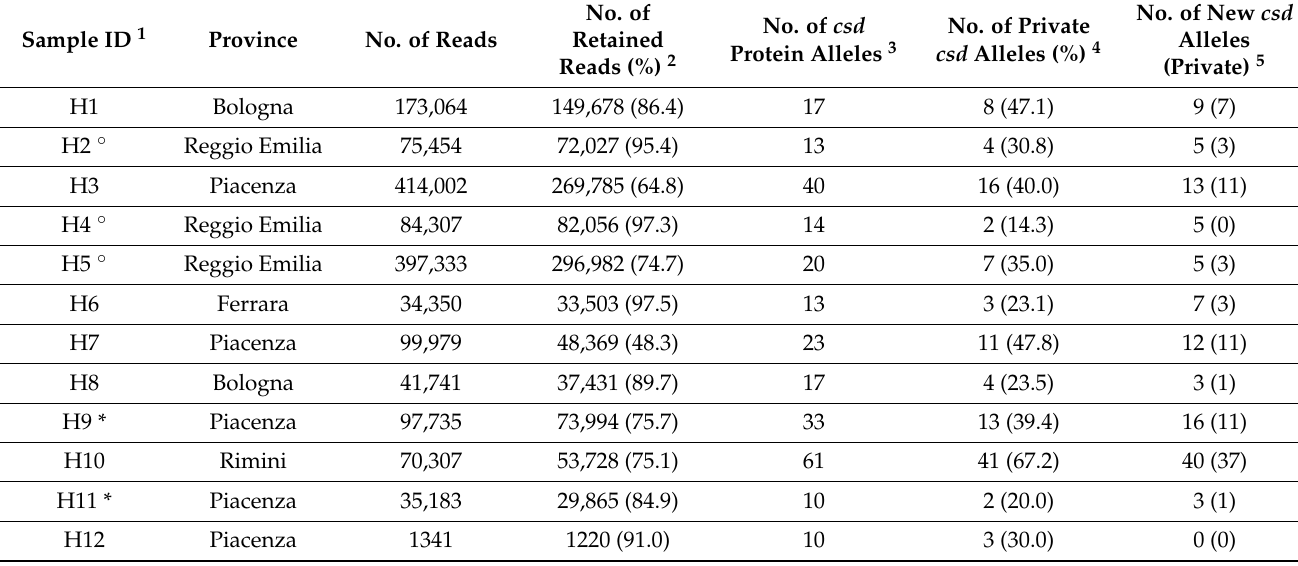
1 Samples provided by the same beekeeper are marked with the same symbol (* or ◦ ). 2 Reads coding for valid alleles (see quality checks described in Section 2.4.2). Percentage is relative to the analyzed sample over the number of all reads obtained for that sample. 3 Number of valid alleles determined after the application of the filtering criteria reported in Section 2.4.2. 4 Number of csd protein alleles identified only in that sample. The percentage is over the total number of csd protein alleles obtained for that sample. 5 Number of new csd protein alleles. The number of private alleles that were also new is reported within